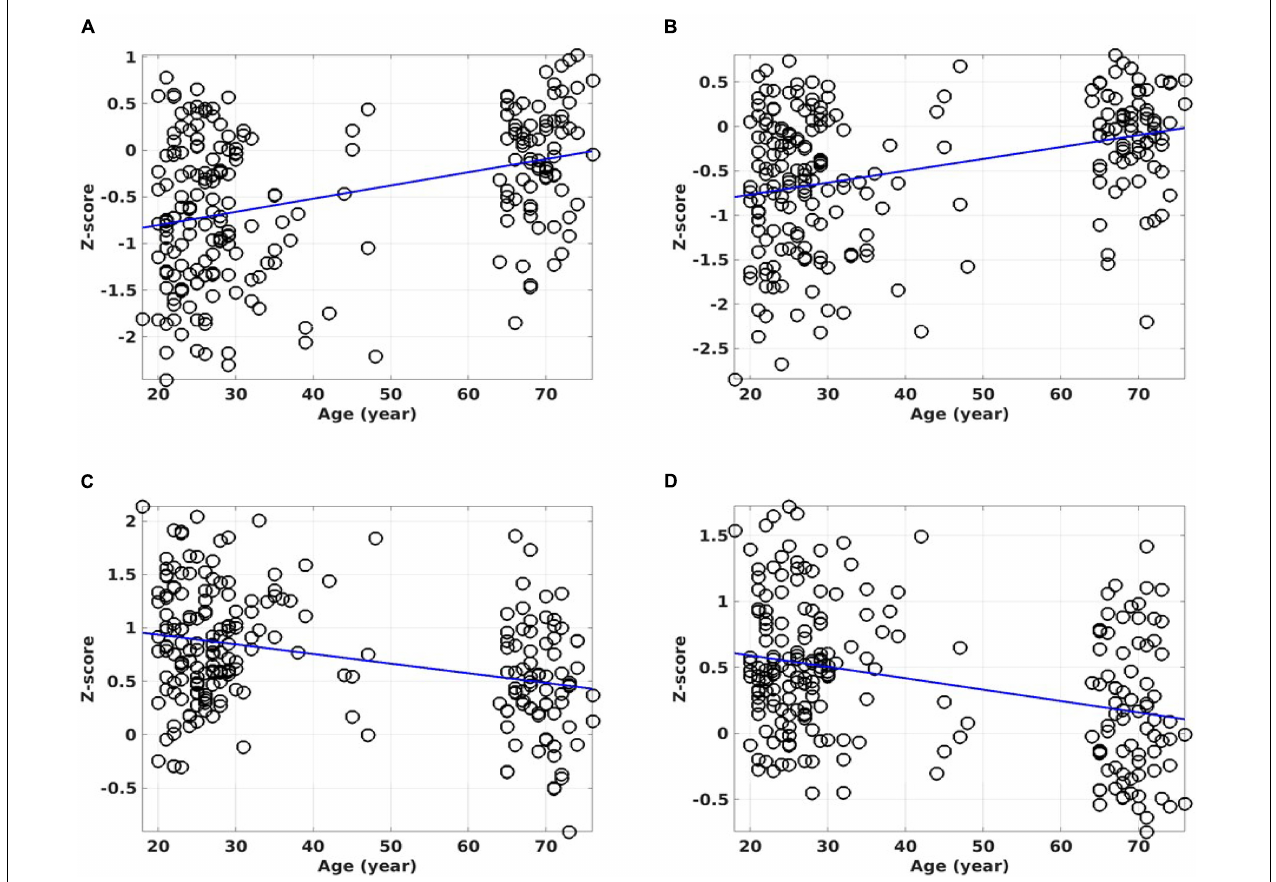
FIGURE 9 | Scattered plots of the regression against age for the overlapping results between the CSI N and the CSI P metrics (see the bottom rows of Table 1 ). The ROI average of the CSI N metric against the subject’s age for the overlapping ROI in the PCC (A) . The ROI average for the CSI N metric against the subject’s age for the overlapping ROI in the right insula cortex (B) . The ROI average for the CSI P metric against the subject’s age for the overlapping ROI in the PCC (C) . The ROI average for the CSI P metric against the subject’s age for the overlapping ROI in the insula cortex (D) . The lines show the linear regression results of the RFC metrics against the subject’s